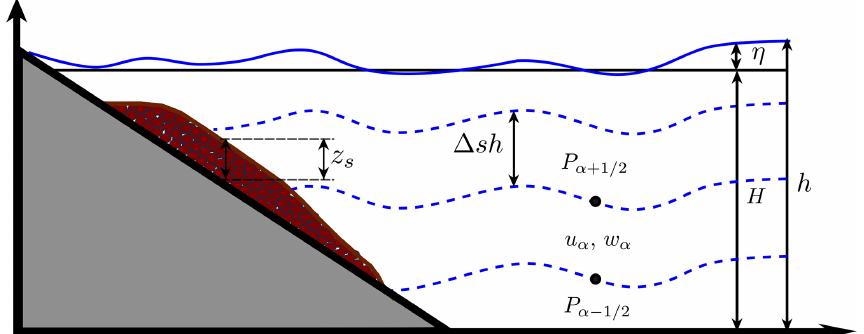
Figure 1. Schematic diagram describing the multilayer